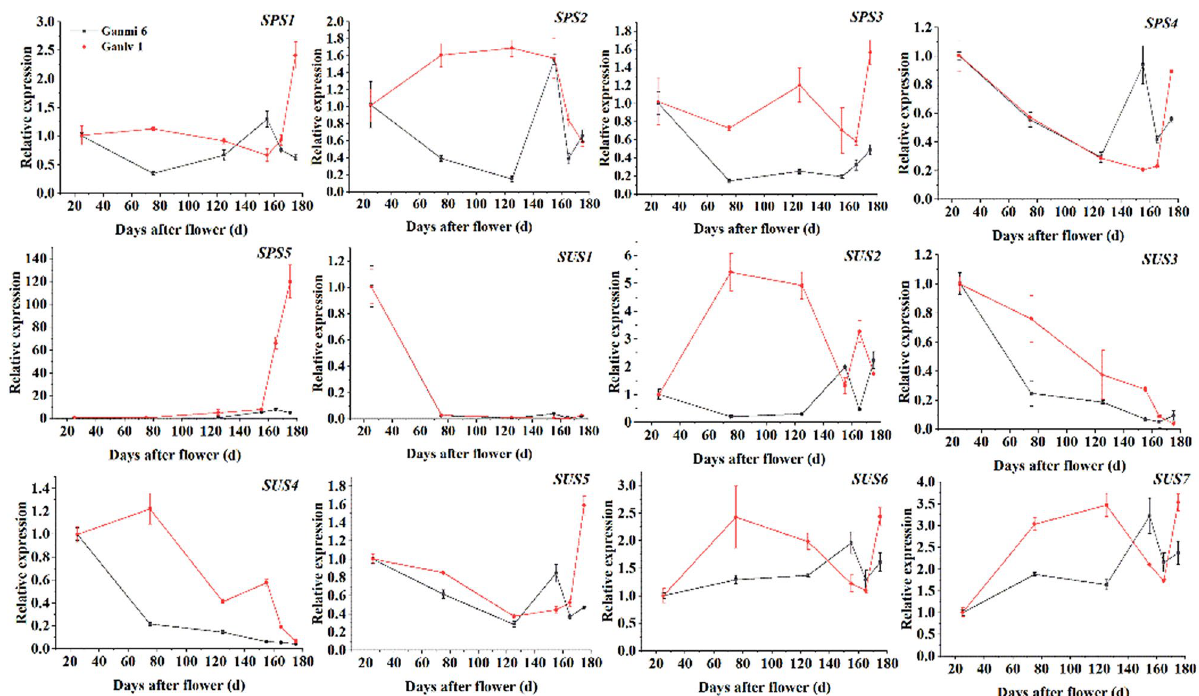
Figure 5. Relative expression of AcSP S and AcSUS gene family in